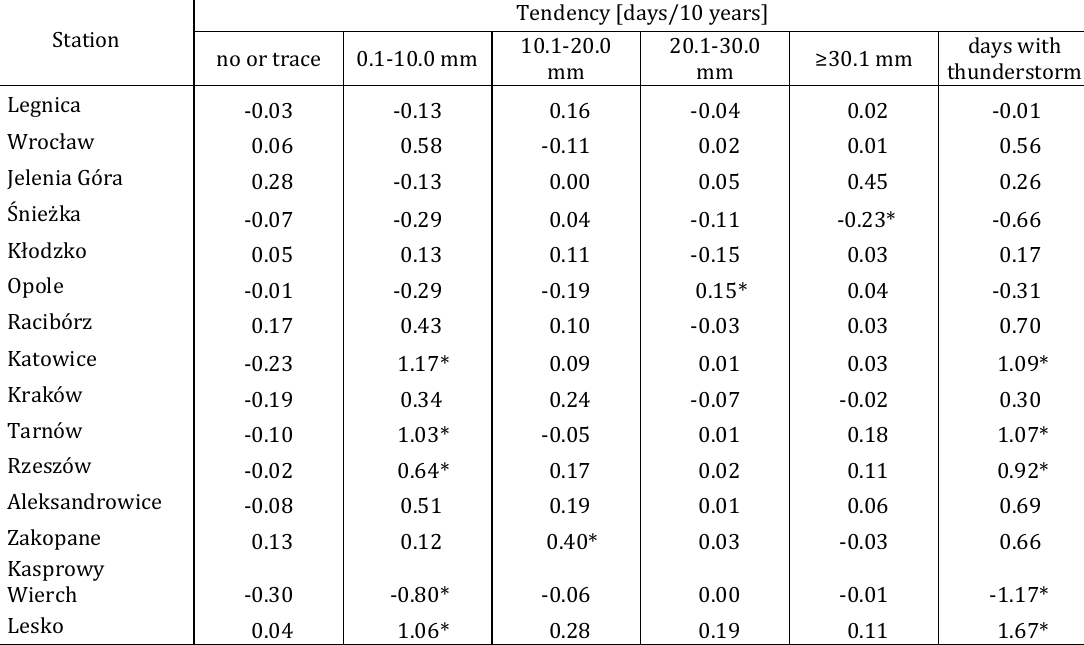
1.25* – value statistically significant at